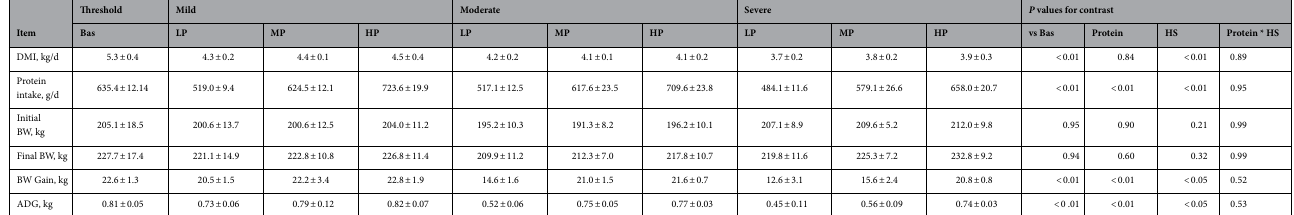
Threshold Mild Moderate Severe P values for contrast Bas MP HP LP MP HP LP MP HP vs Bas Protein HS Protein *